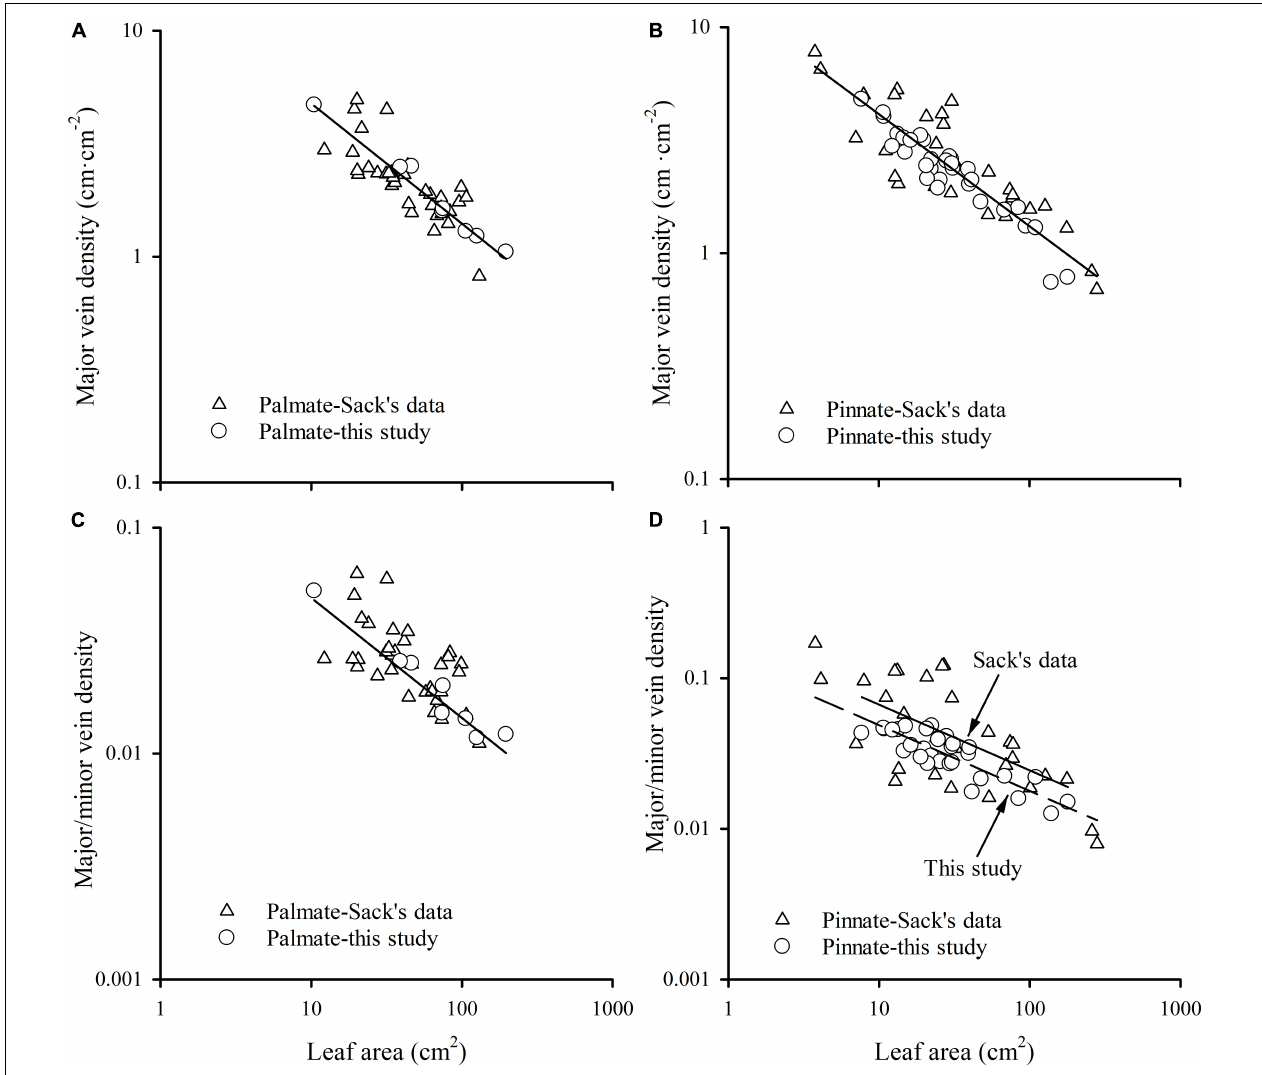
FIGURE 4 | The relationships of major vein density of palmate-veined species (A) , major vein density of pinnate-veined species (B) , the ratio of major to minor vein density of palmate-veined species (C) , and the ratio of major to minor vein density of pinnate-veined species (D) with leaf